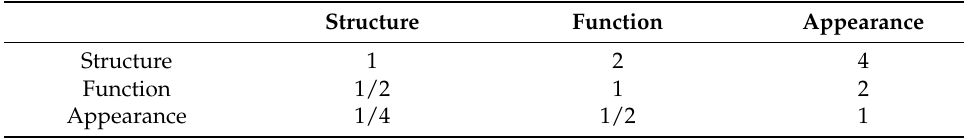
Table 4. The customer bias in the evaluation